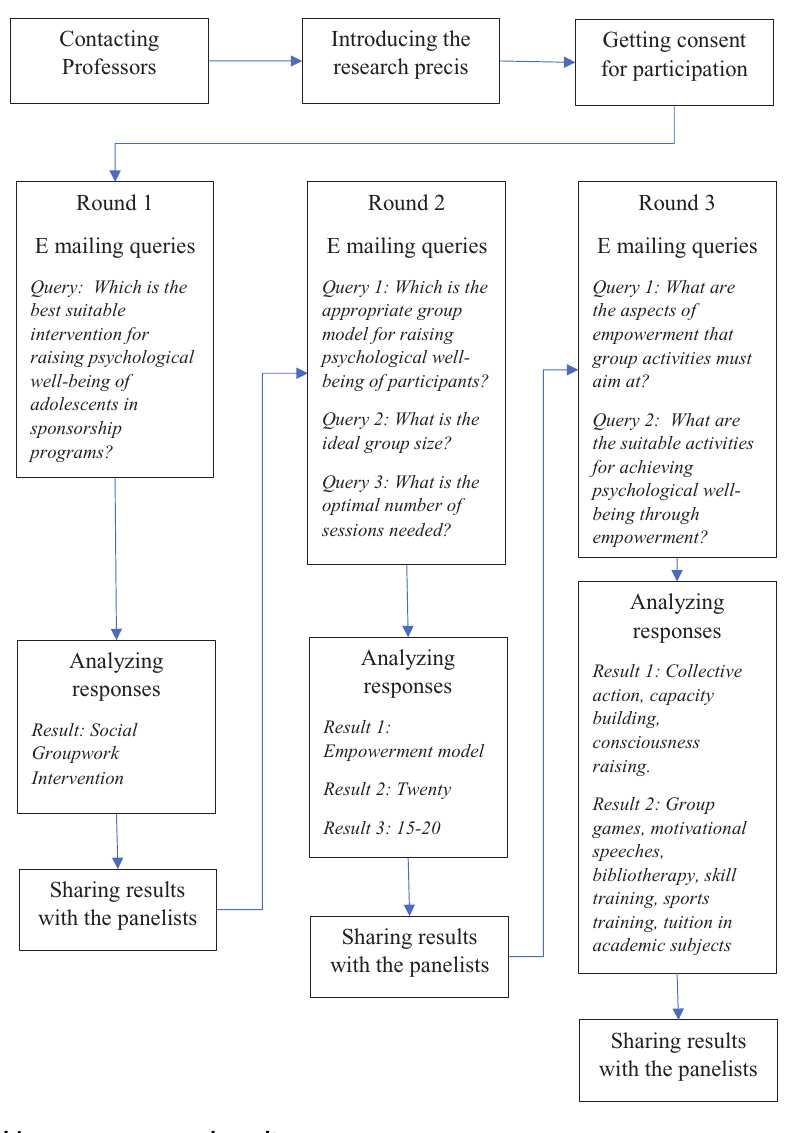
Figure 1. Delphi survey process and